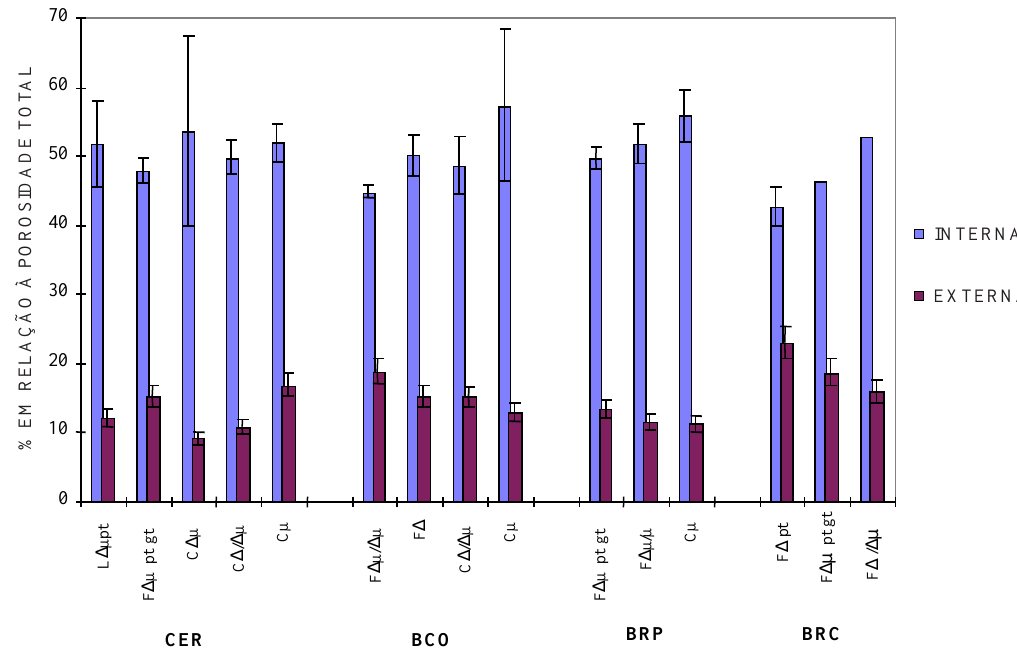
Figura 3. Porosidades (fissural e interna) dos torrões dos volumes estruturais.